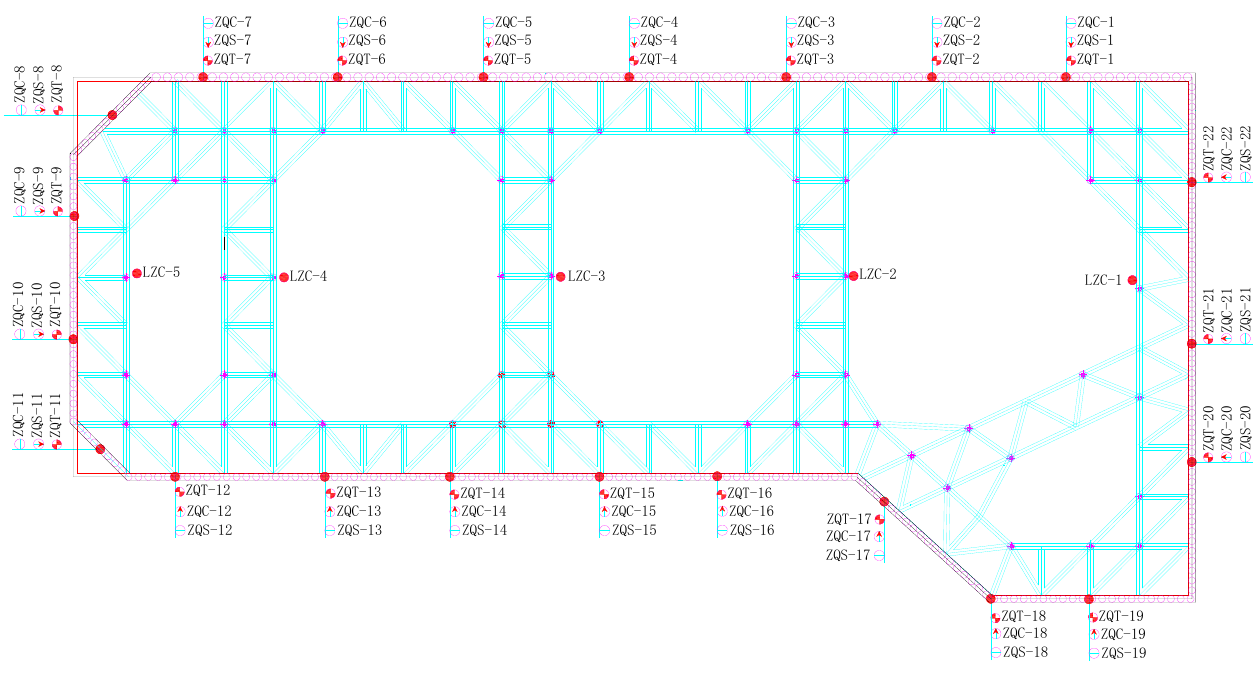
Figure 3. Schematic diagram of the layout of some monitoring points in the foundation pit. A total of 14 measuring points for station automatic monitoring (ZDH-1~ZDH-14) are arranged near the sidewall of the station near the foundation pit. There are 10 artificial monitoring points for station lateral deformation (CZH-1 ~ CZH-10), 8 artificial monitoring points on the left side (ZZC-1 ~ ZZC-8) and 14 artificial monitoring points on the right side (YZC-1 ~ YZC-14). The right track structure has 16 vertical monitoring points (YGD-1~YGD-16) and 16 horizontal displacement monitoring points (YGS-1~YGS-16), and the left track structure has 10 vertical monitoring points (ZGD-1~ZGD-10) and 10 horizontal displacement monitoring points (ZGS-1~ZGS-10). There are nine vertical monitoring points (C-1 ~ C-9) and six horizontal monitoring points (CH-1 ~ CH-6) at the entrance and exit. The order of the monitoring points of the main body of the station and the track is from north to south, and the order of the vertical displacement monitoring points at the entrance and exit starts from one side of the station and rotates counterclockwise along the entrance and exit structure. The layout of the deformation monitoring points of the station and track structure is shown in Figure 4. Figure 4. Schematic diagram of the station and entrance structure monitoring layout.